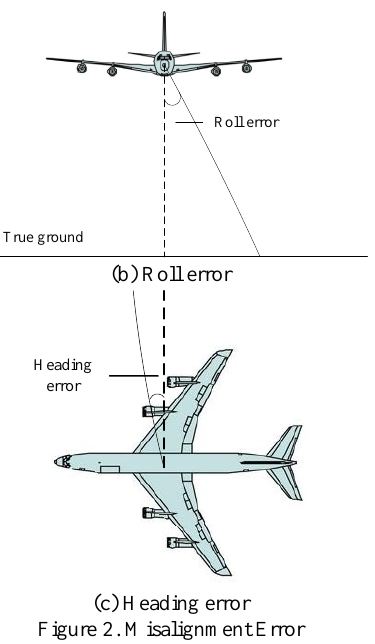
(c) Heading error Figure 2. Misalignment Error